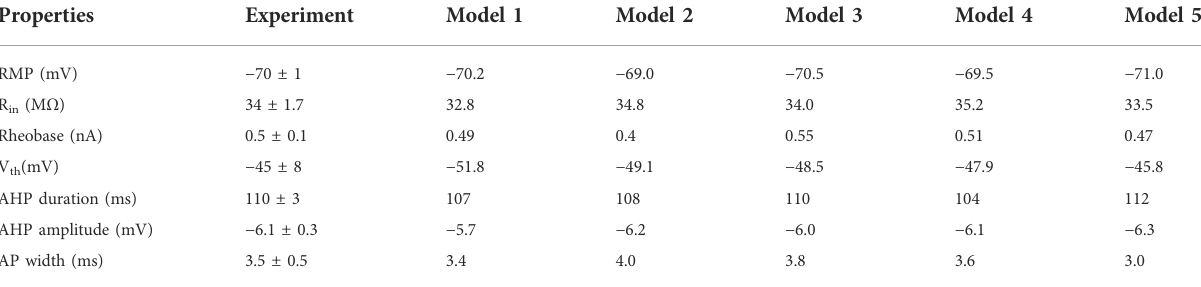
TABLE 1 Membrane properties of hypoglossal motoneuron.